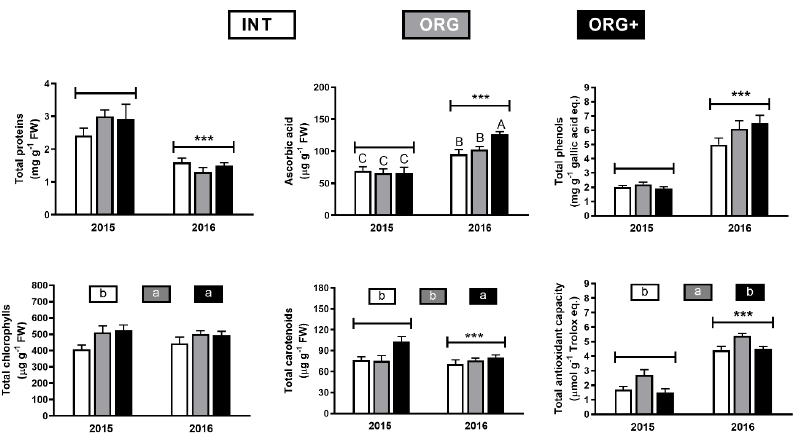
Figure 2. Total proteins, ascorbic acid, total phenols, total chlorophylls, total carotenoids, and total antioxidant activity of summer lettuce cultivated according to three different cropping system: integrated (INT), organic farming (ORG), and organic no-tillage (ORG+) in a two-year experiment. Each value is the mean ± SD of three replicates. Means keyed with the same capital letter are not significantly different for p = 0.05 following two-way ANOVA using production year (2015–2016) and the three different cropping systems (INT, ORG, and ORG + ) as the variability factors. When the F ratio in the two-way ANOVA interaction was not found significant, data were analyzed by one-way ANOVA using year of cultivation or cultivation systems (considering the average of two years of production) as the variability factor. The presence of asterisks denotes significant differences for p < 0.05 following one-way ANOVA using production year as the variability factor (*** p < 0.001), whilst the presence of different lowercase letters denotes significant differences for p < 0.05 following one-way ANOVA using cropping systems as the variability factor.